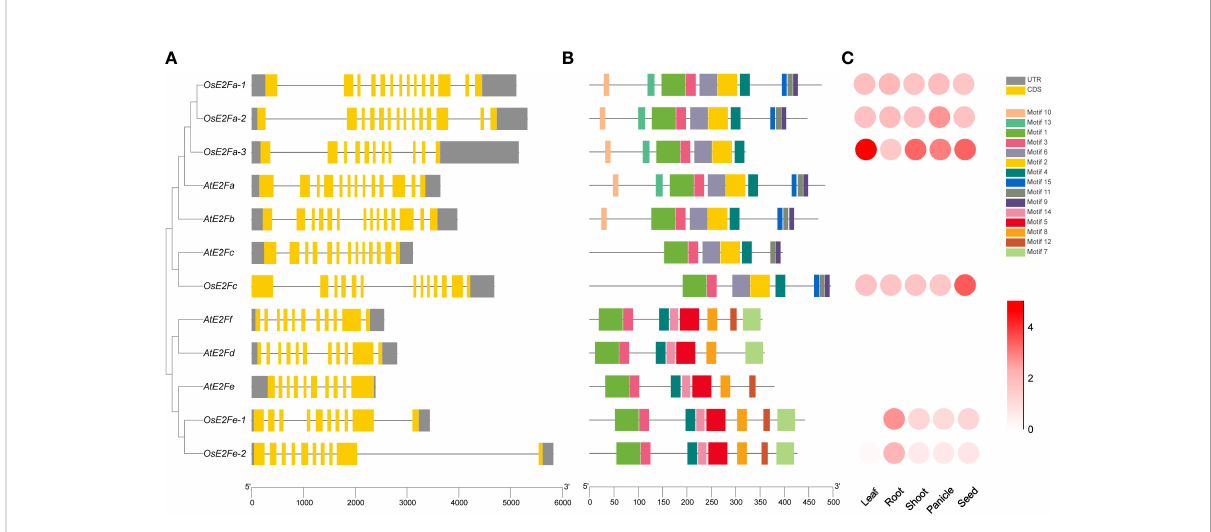
FIGURE 1 Phylogenetic tree, gene structure, conserved structural domains, and expression pattern analysis of rice and Arabidopsis E2Fs (A) On the left is the phylogenetic tree of the rice and Arabidopsis gene families. The gene structures are shown on the right. Exons and UTRs are indicated by boxes, while gray lines indicate introns of genes, respectively. (B) The distribution of motifs in the amino acid sequence. Patterns are indicated by different colored boxes. The scale at the bottom indicates the gene length. (C) Expression patterns of rice E2Fs in different tissues, with white indicating the lowest expression and red the